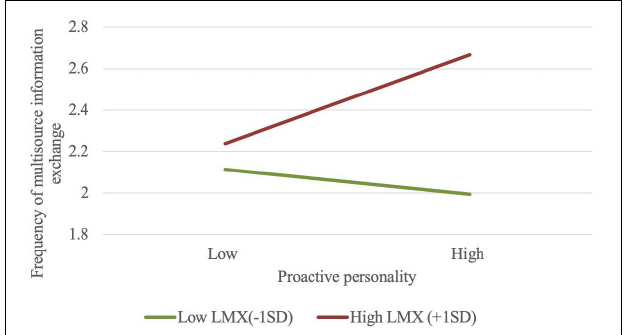
FIGURE 3 | Interaction plot of proactive personality and LMX on the frequency of multisource information